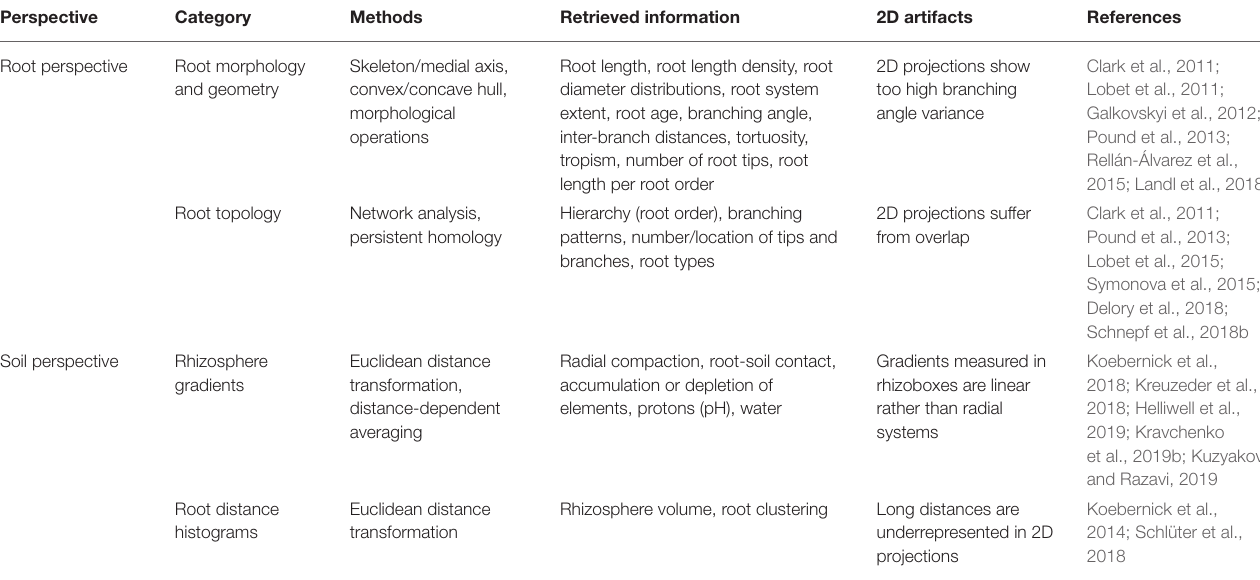
TABLE 3 | Summary of methods for 3D pattern analysis of root system